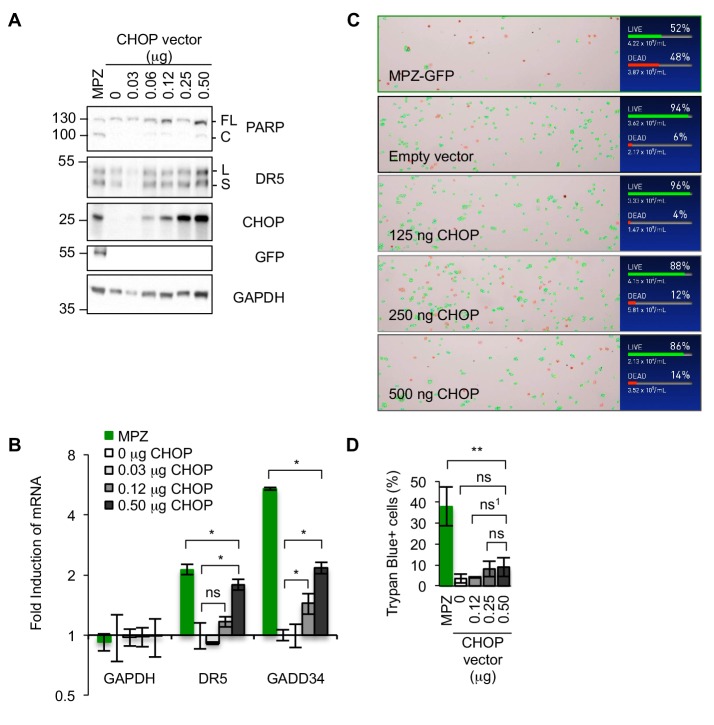
Upregulating DR5 levels in the absence of ER stress through ectopic expression of CHOP is not sufficient to induce apoptosis.(A) Western blot of HCT116 cell lysates harvested 24 hr post-transfection with a titration of 0.03–0.50 μg of a CHOP expression vector, 1 μg MPZ-GFP plasmid, or the empty vector (FL = full length, C = cleaved). (B) qPCR for reverse-transcribed transcripts harvested from HCT116 cells transfected with 0.03–0.50 μg of a CHOP expression vector, 1.0 μg of MPZ-GFP, or 1.0 μg of the empty vector for 24 hr (n = 3 technical replicates, error bars = SD, * denotes p<0.05). (C) Representative images of automated counting for Trypan blue-stained cells, where green outlines denote non-stained (live) cells and red outlines denote stained cells (Trypan blue+, dead). (D) Average percentage of cells transfected as described in (S3A) stained with Trypan blue as quantified by automated cell counting from n = 3 biological replicates (error bars = SEM; ** denotes p=0.008 and ns = non significant for unpaired t-test with equal SD; ns1 refers to p=0.19 from unpaired t-test with Welch’s correction for variance).